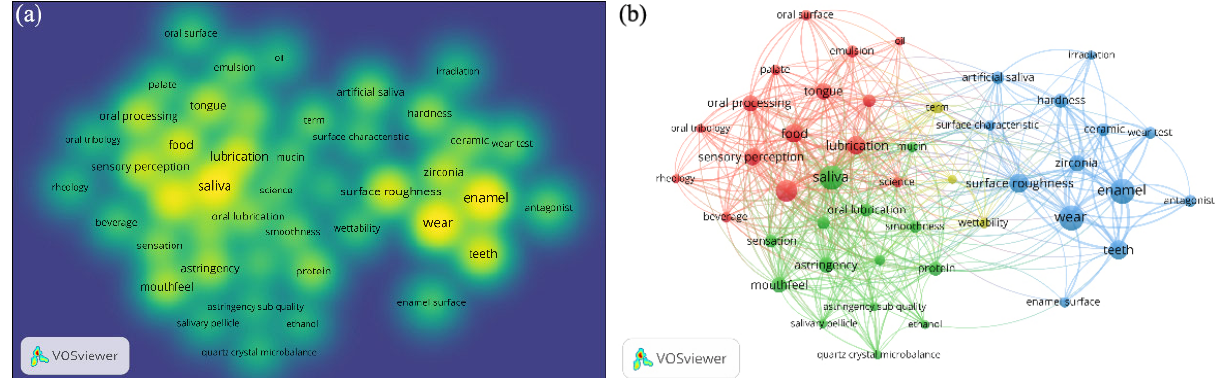
Fig. 40 (a) Density and (b) network diagrammes of oral